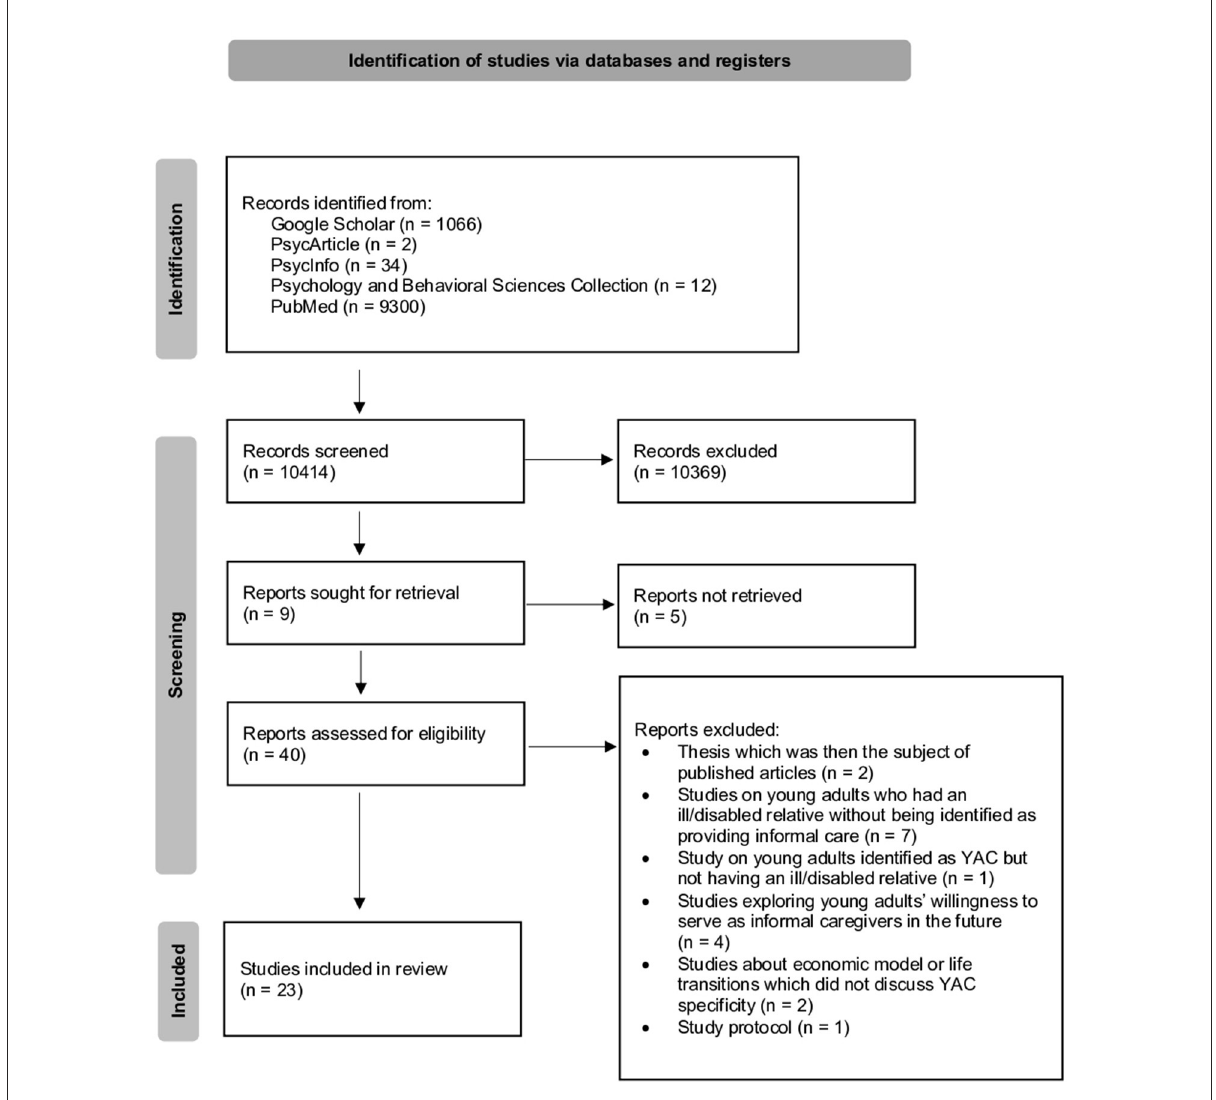
FIGURE1 PRISMA flow